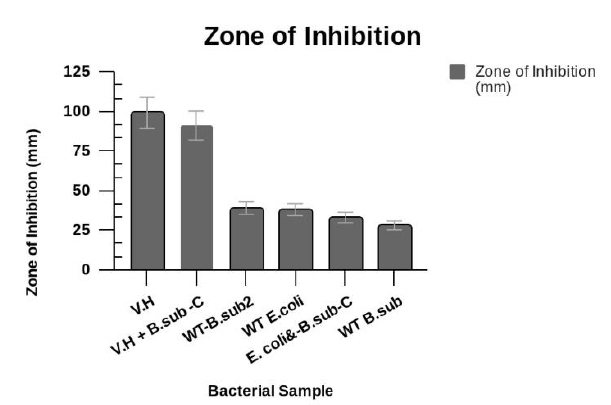
Figure 5 : Zones of Inhibition (mm) The zones of inhibition were measured in millimeters. The zone of inhibition for V. harveyi totaled to 99 and 91 for B. subtilis-Carrier-V.H. WT E. Coli had a total zone of inhibition of 38 as B. subtilis-Carrier-E. Coli yielded a total Zol of 33. Wild-type V. harveyi and E. Coli samples showed increased antibiotic sensitivity, however, the B. subtilis Carrier-V.H and B. subtilis Carrier-E. Coli co-cultures increased in antibiotic